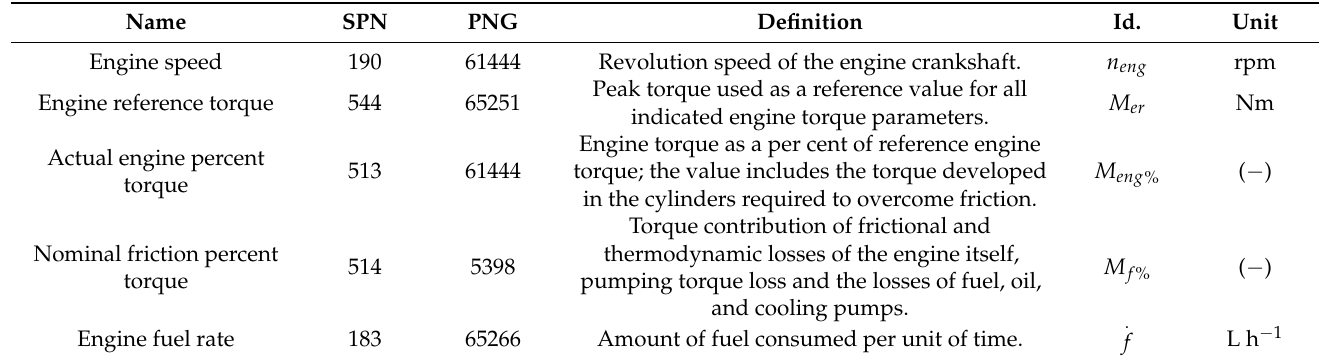
Table 5. Signals